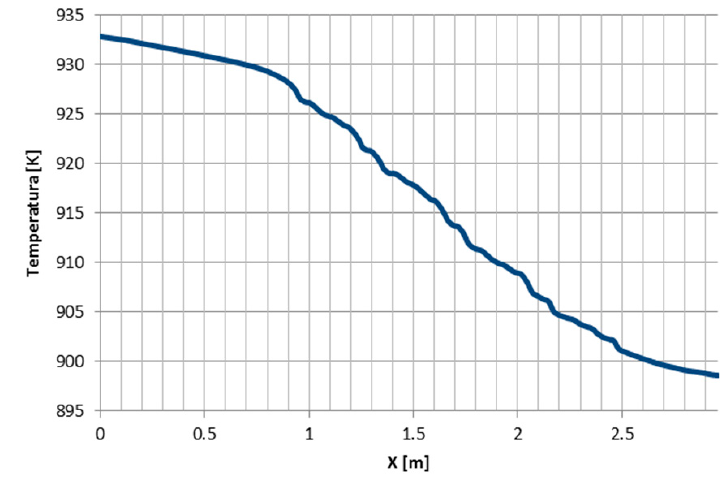
Figure 19. Cooling curve of the band along the midline.